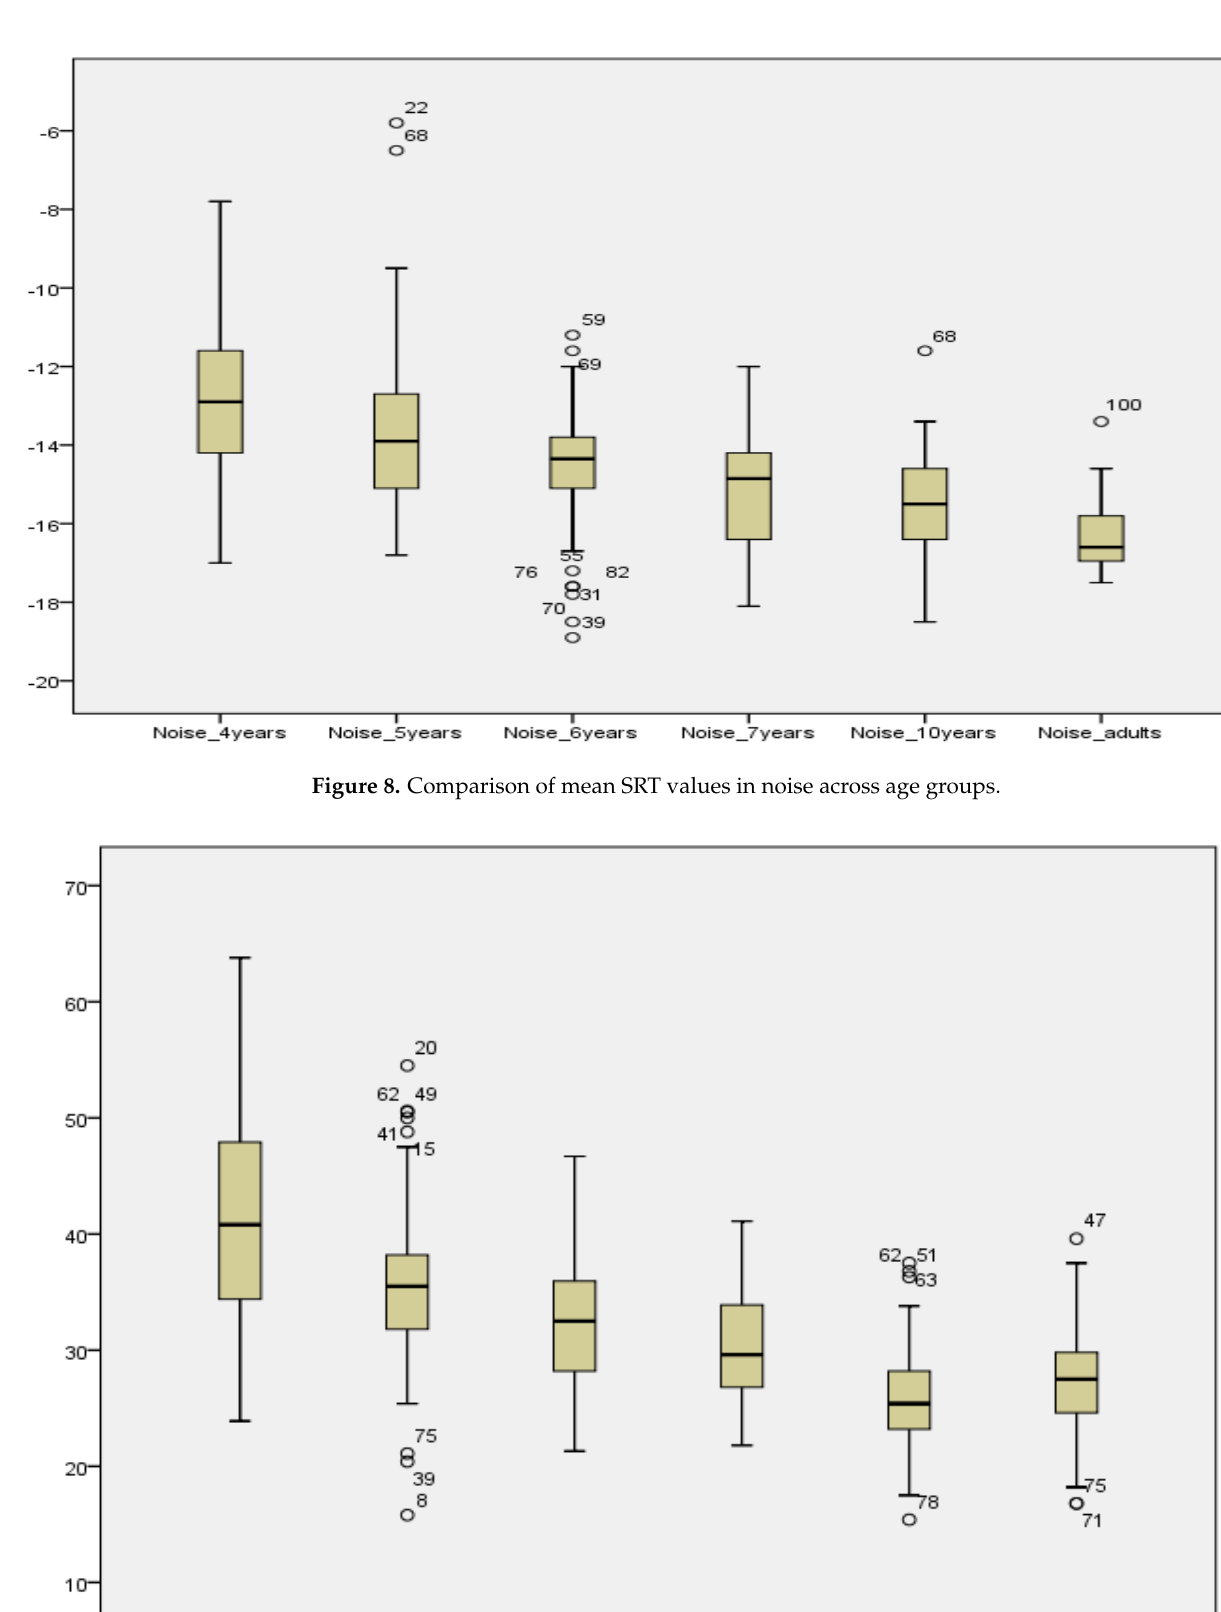
Figure 7. Comparison of mean SRT values in quiet across age groups.